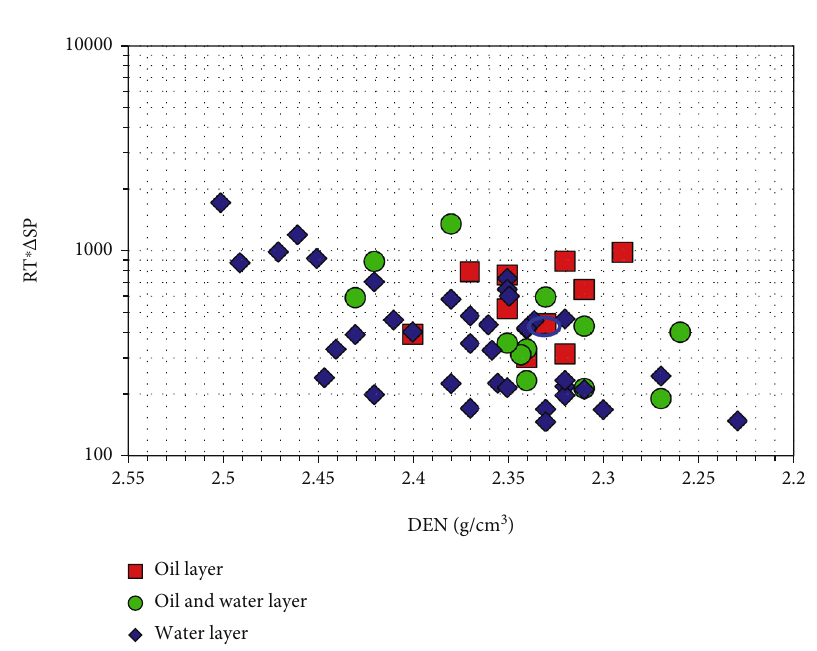
Figure 13: Cross plot of DEN- AT90 ∗ Δ SP